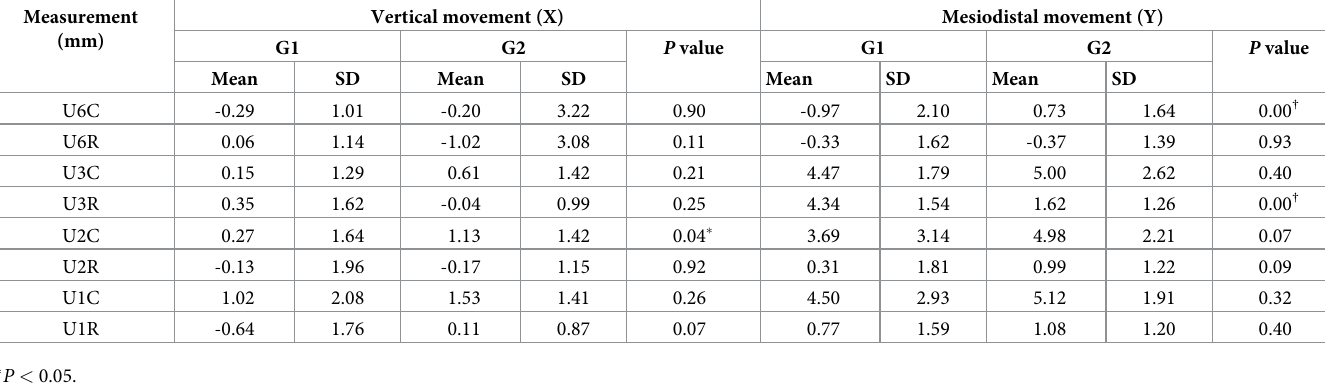
Table 2. Linear changes (T1—T2) in landmarks in the vertical (X) and mesiodistal (Y) directions. Measurement (mm)